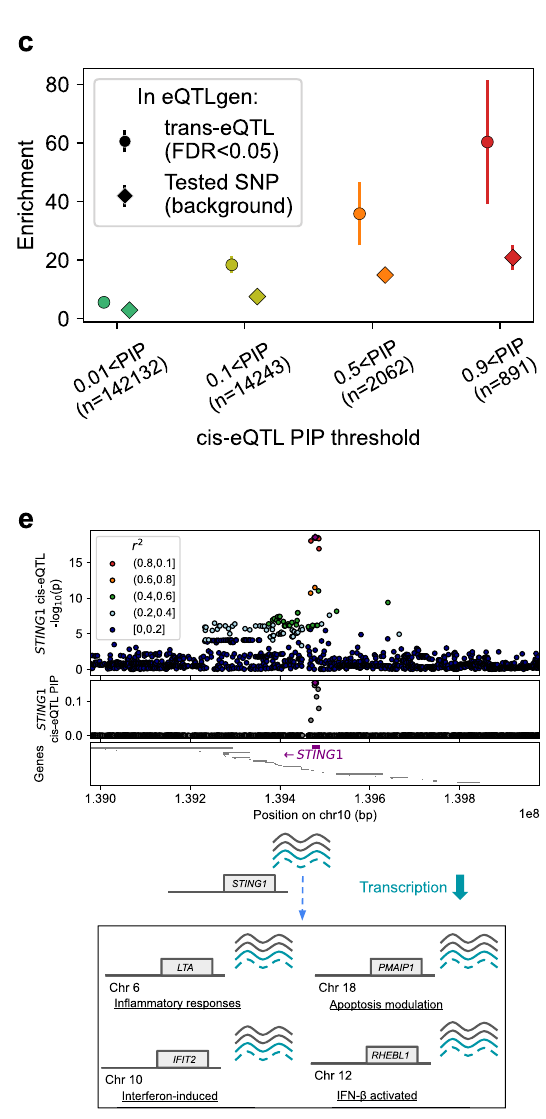
or assessed in eQTLgen (diamond) relative to all the variants in our dataset, for variants with different maximum cis-eQTL PIP ( x -axis). d , e Association p value (top),cis-eQTLPIP(secondrow)andthelocationofthegenes(thirdrow)for±1Mb ( d ) or 0.5Mb ( e ) of the variant with possible trans-eQTL effects mediated by cis- eQTLeffects,withschematicoverviewofthetrans-eQTLmechanisms.Bluedotted line represents the decrease of the effect (arrow; positive, non-arrow; negative).